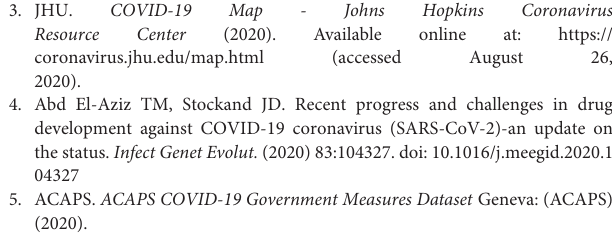
Supplementary Figure 1 | Flowchart for methodology. Supplementary Figure 2 | Overall situation of the COVID-19 pandemic in Eastern Mediterranean countries: (a–f) overall situation of the COVID-19 pandemic in Iran, Saudi Arabia, Pakistan, Iraq, Qatar, and Egypt, respectively. Supplementary Figure 3 | Overall growth rates in total number of confirmed cases: (a–f) subgraph showing Iran, Saudi Arabia, Pakistan, Iraq, Qatar, and Egypt — exp model, a linear fit to an exponential law in log scale; glm-Poisson, a general linear regression Poisson model; GLM-gamma, a general linear regression gamma model method. Supplementary Table 1 | Machine-learning methods to forecast the trend of COVID-19. Supplementary Material 1 | R code for non-pharmaceutical intervention